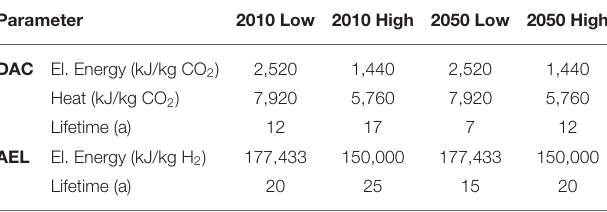
TABLE 5 | System parameters for the sensitivity analysis. TABLE 6 | Total environmental impacts in Germany in 2016 (left) and production volumes of basic chemicals in 2016 (right) (UBA, 2018; VCI,